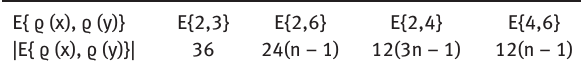
Table 3: Partitions of edges of MON